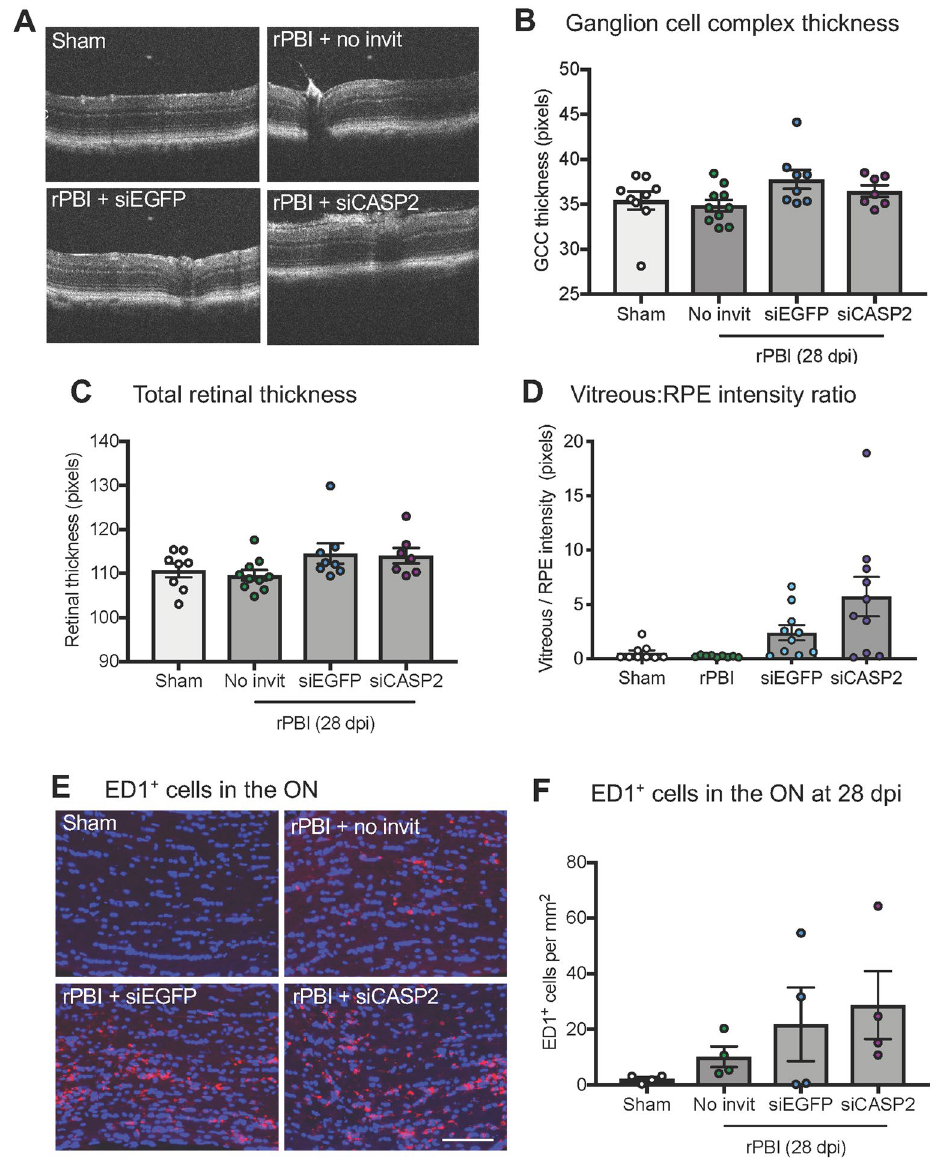
Figure 3. Increased vitreal intensity after “post-blast” siCASP2 intravitreal injections, but no changes in retinal thickness and ED1 + cells in the ON after b-ITON. ( A ) Representative OCT scans. ( B ) There were no difference in GCC thickness between any groups (P = 0.121, ANOVA). ( C ) Vitreous intensity normalised to RPE intensity increased after b-ITON with siEGFP and siCASP2 intravitreal injections compared to b-ITON with no injections (P = 0.001, GEE) and in eyes receiving siCASP2 injections compared to siEGFP injections (P = 0.002, post-hoc Tukey). ( D ) There were no differences in total retinal thickness between any groups (P = 0.1012, ANOVA). ( E ) Representative ON immunofluorescent images stained for DAPI (blue) and ED1 (red). ( F ) ED1 + cells infiltrate the ON after b-ITON and with “post-blast” injections, although ED1 + cell counts did not reach significance (P = 0.23, ANOVA). Scale bar for ( E ) = 100 μm. Error bars represent mean ±